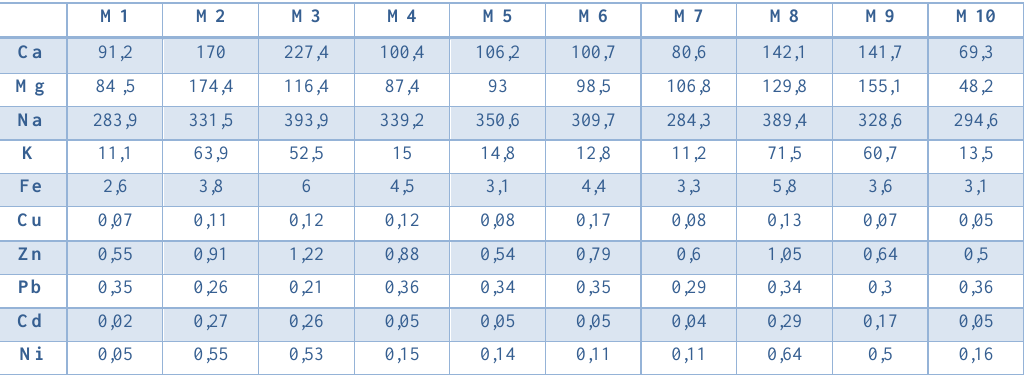
Table 1 : concentration of heavy metals in average Moulouya